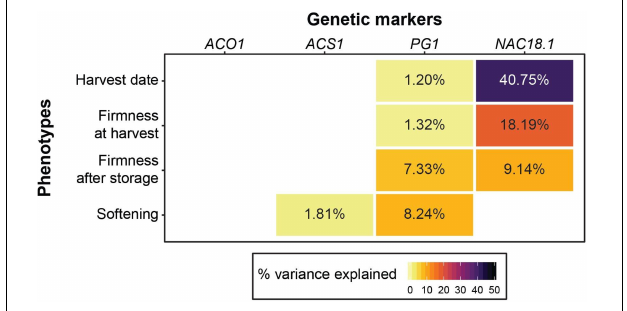
FIGURE 1 | The utility of four genetic markers for predicting harvest date and firmness-related apple phenotypes. For each trait, the percent variance explained for each of the four markers is shown in cases where a significant effect was detected from a type 2 ANOVA. A type 2 ANOVA was also performed with the four genetic markers and harvest date as a co-factor ( Supplementary Figure 3